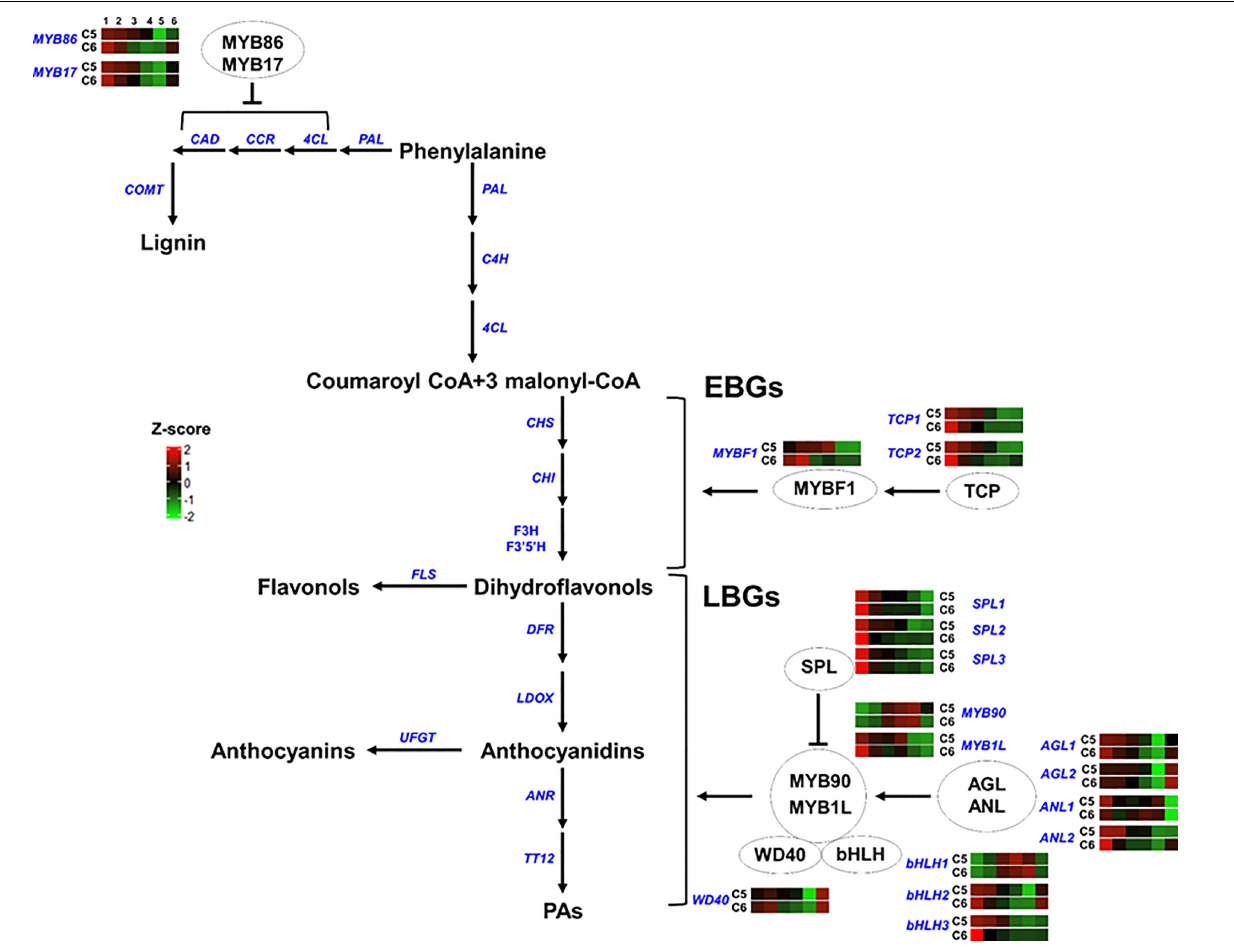
FIGURE 8 | Transcription factors regulating the phenylpropanoid/flavonoid pathway. The colored boxes show the accumulation pattern of genes involved in the regulation of flavonoid and lignin pathway that were assessed by qPCR at different berry developmental stages, including fruit-set (1), prevéraison (2), véraison (3), postvéraison (4), ripe-skin/flesh (5), and ripe-seeds (6). Red boxes indicate higher levels of expression, and green boxes indicate lower expression levels. The color brightness is directly proportional to the expression ratio, according to the color scale. MYB , myb-related regulatory gene; TCP , teosinte